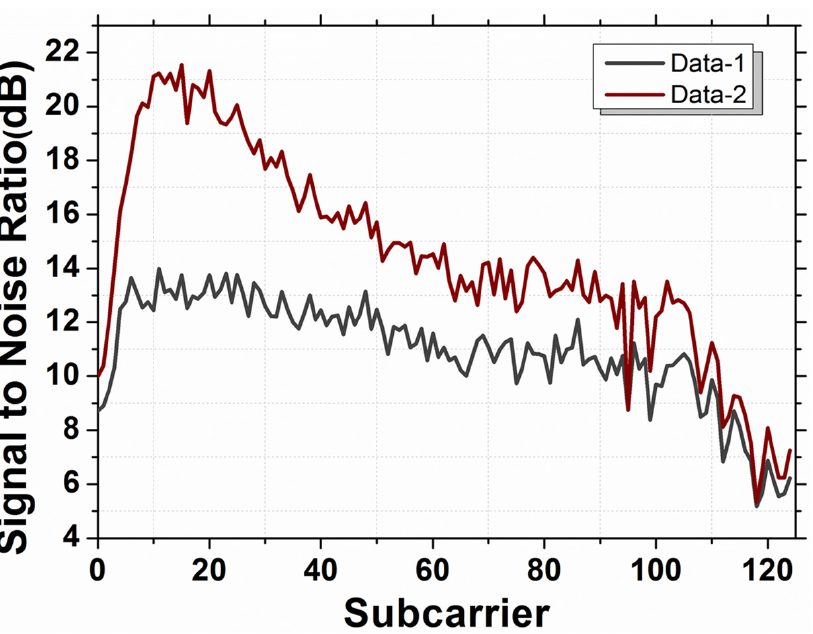
Figure 6. Measured SNRs of the two individual signals against all the OFDM subcarriers in the proposed PowDM VLC system.